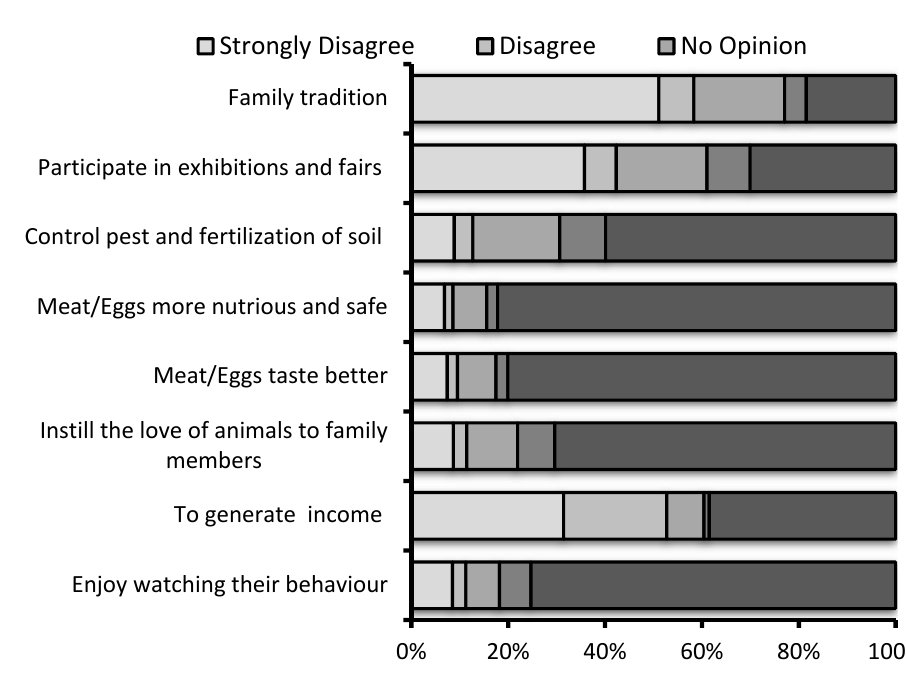
Figure 3. Backyard poultry owners’ reasons for keeping poultry.